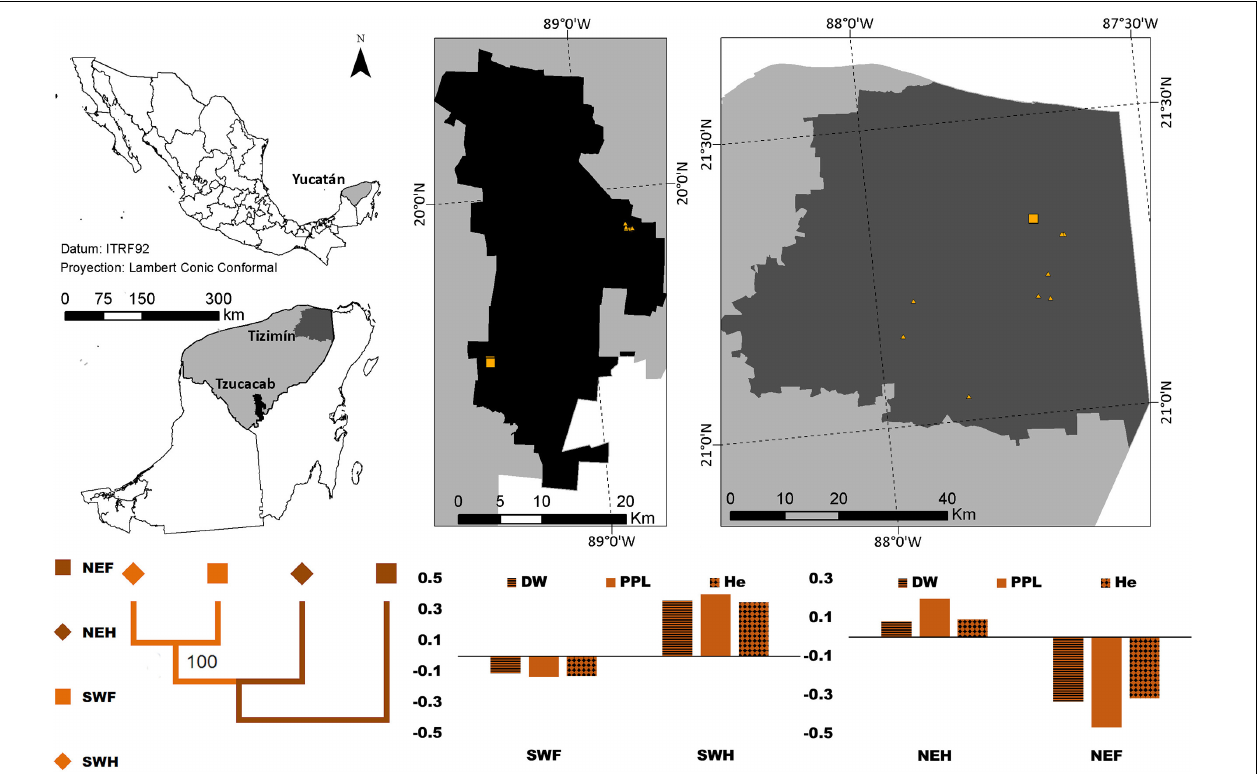
FIGURE 2 | Distribution of forest (square) and homegarden (triangle) individuals of Cordia dodecandra in two regions of Yucatán, México. The graphic depicted the standardized mean values for PPL-horizontal lines, DW -solid color, and He-diamond pattern [ (cid:0) x i − x (cid:1) / x where x i is the mean value per region/population type and x the overall mean value]; negative and positive values indicate values below and above the overall mean. The dendrogram for the paired F ST between each combination of the region (northeast -NE- dark orange, and southwest-SW- light orange) and population type (forests -squares- and homegardens -diamonds-) suggests almost no differentiation between the southwestern forest and the northeastern homegarden population with a 100% bootstrap support, and this group and the northeastern